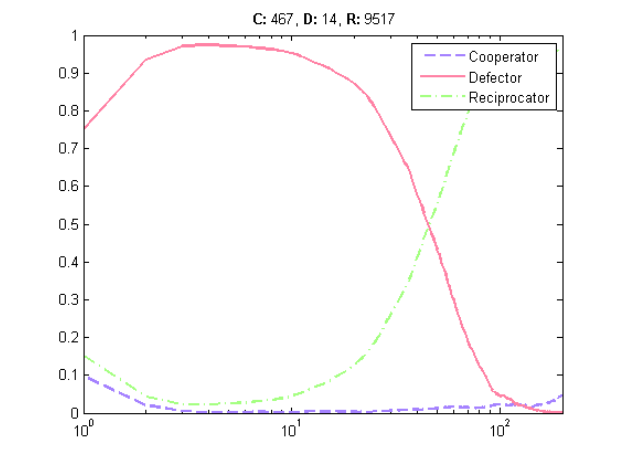
Figure 6. Strategy distribution in each game round.